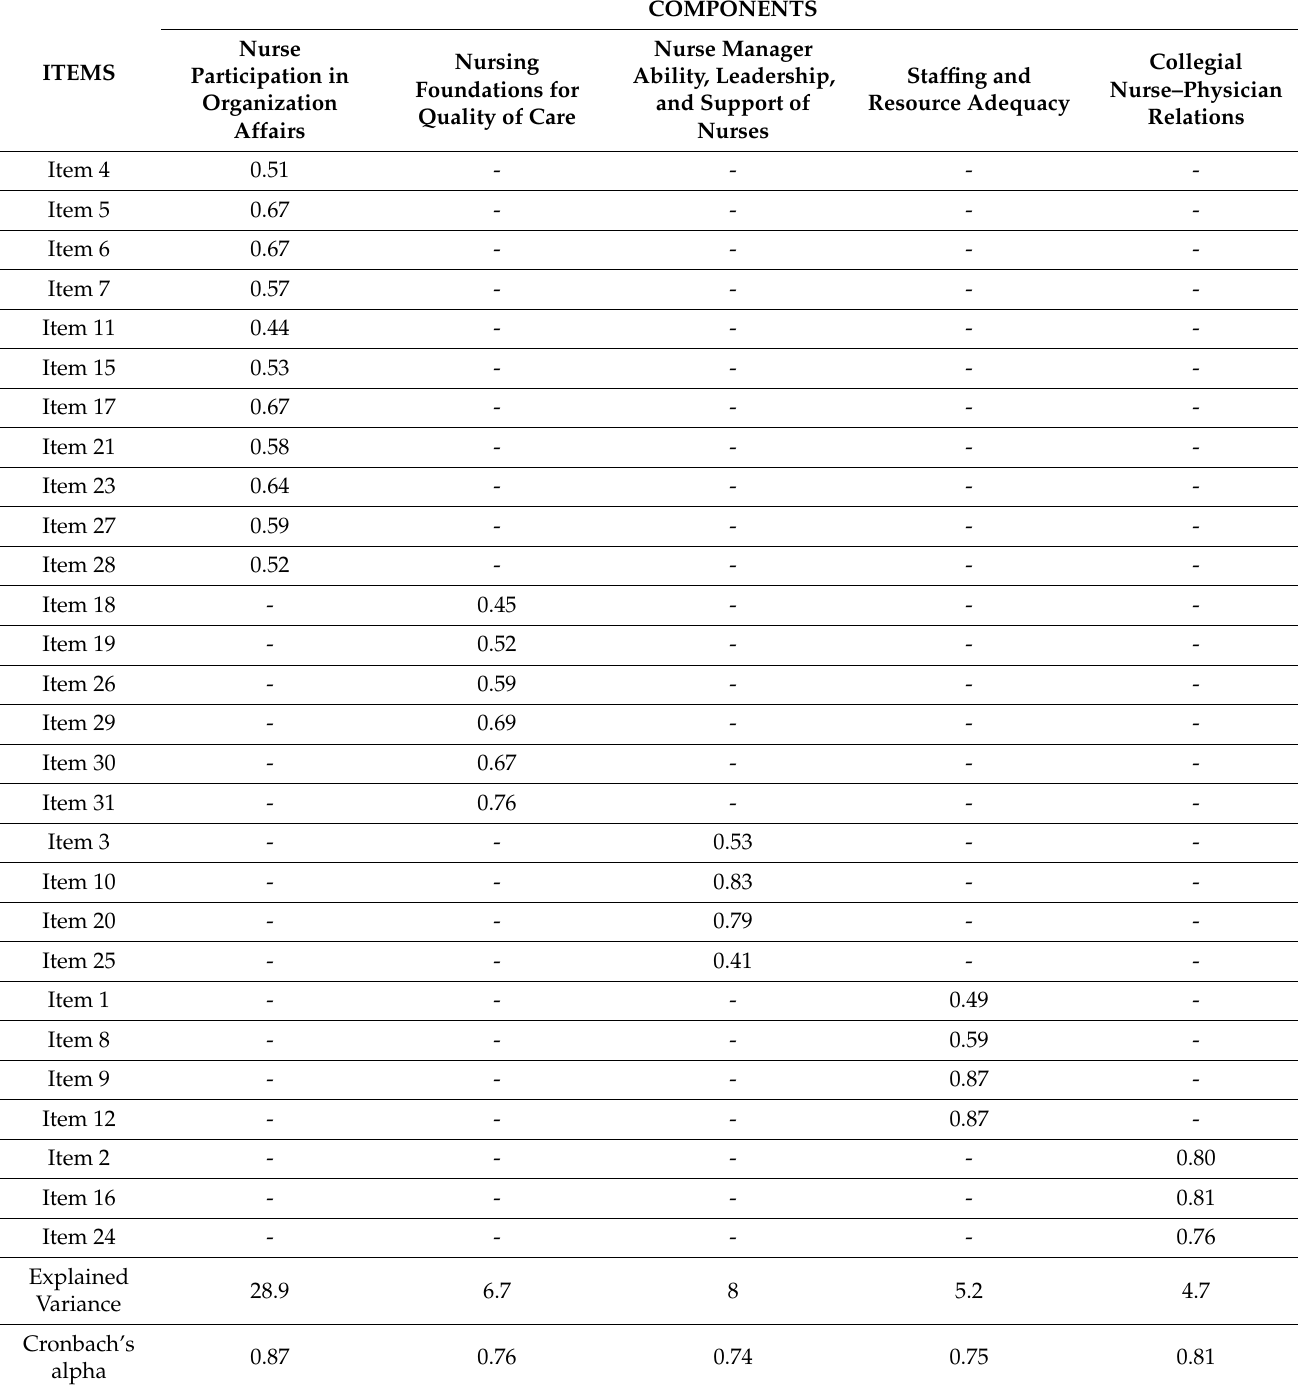
Staffing and Resource Adequacy